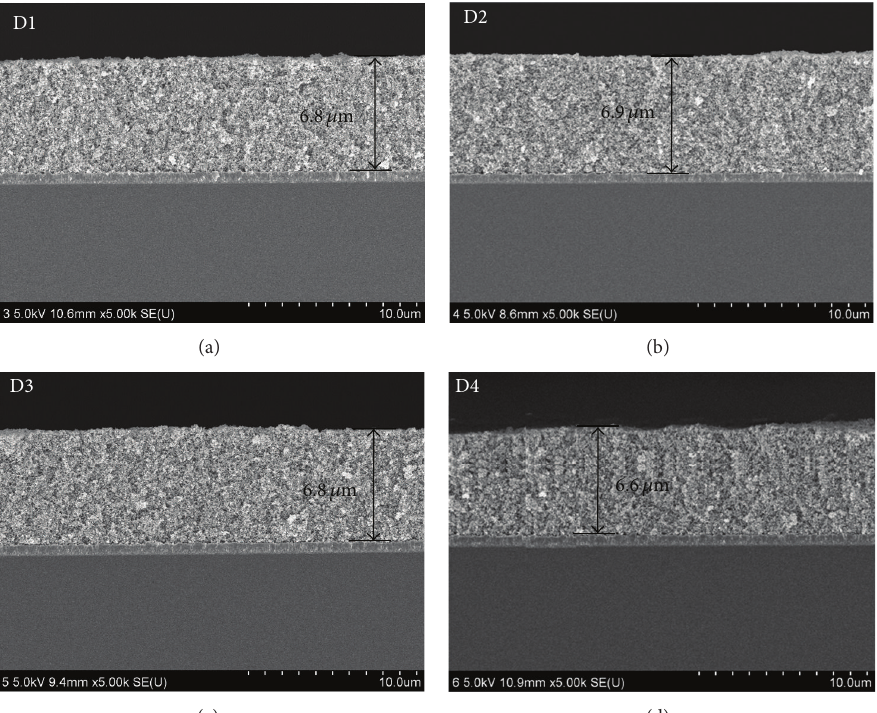
Figure 3: FE-SEM images of the cross-section of chitosan sol-based TiO 2 films.